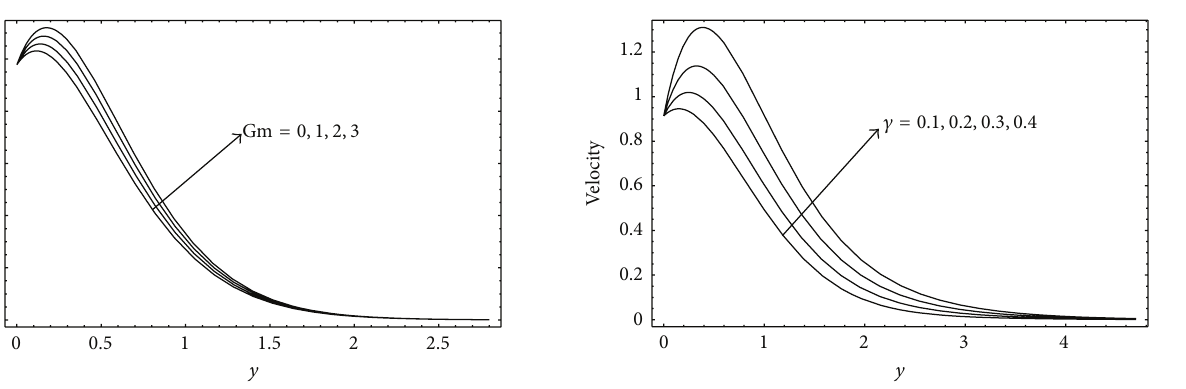
Figure 6: Velocity profiles for different values of Gm when 𝑡 = 0.2, 𝑅 = 1, Pr = 0.71, Gr = 5, Sc = 0.78, 𝛾 = 1 , and 𝜔 = 𝜋/3 .